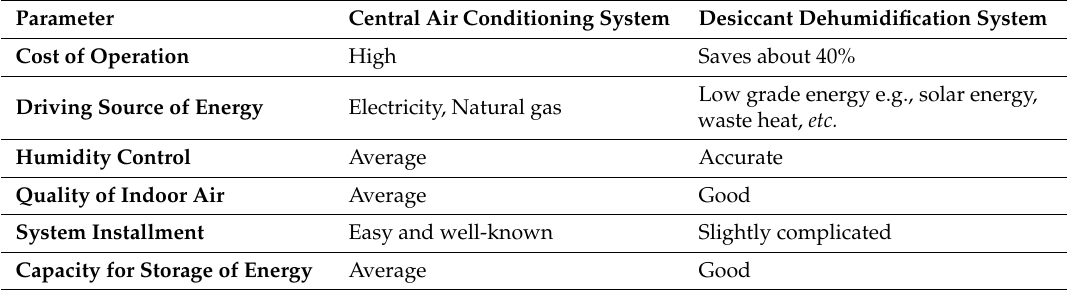
Table 1. Comparison between desiccant cooling system and conventional air conditioning system [20].